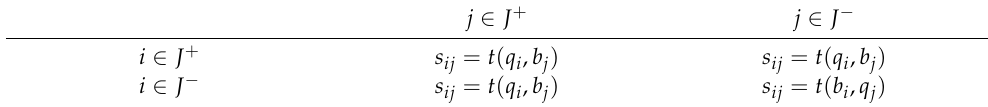
Table 2. Traveling time of AGV transport adjacent tasks on empty